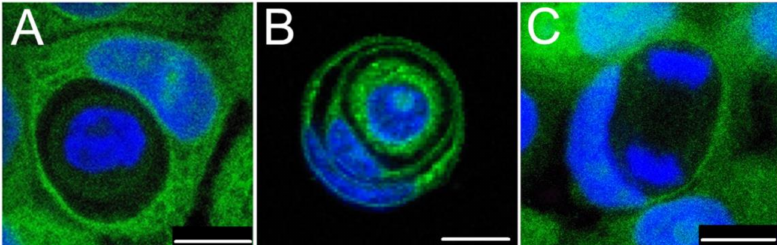
Figure 5. Entosis in BxPC3 cells. Entosis without degeneration ( A ). One single cell is surrounded by the host cell. Membranes of both cells remain intact; the inner entotic cell seems to be localized within a large vacuole formed by the host cell ( B ). Double Cell-in-Cell structure. The internalizing cells are stretched and have a narrow area of the cytoplasm. Their nuclei have a crescent shape ( C ). Metaphase of mitosis of an inner entotic cell inside a cell that exhibits entosis-like appearance, such as the crescent nucleus and stretched cell membranes with a narrow region of cytoplasm. Confocal scan by SP5 Leica confocal microscope. Cytoplasm is stained with CFDA-SE in green and nuclei with DAPI in blue. Scale bar: 10 µ m. Data by Izabela Mlynarczuk-Bialy (M.D., Ph.D.), and Agnieszka Sarnecka (M.D.), and Lukasz Bialy (M.D.,